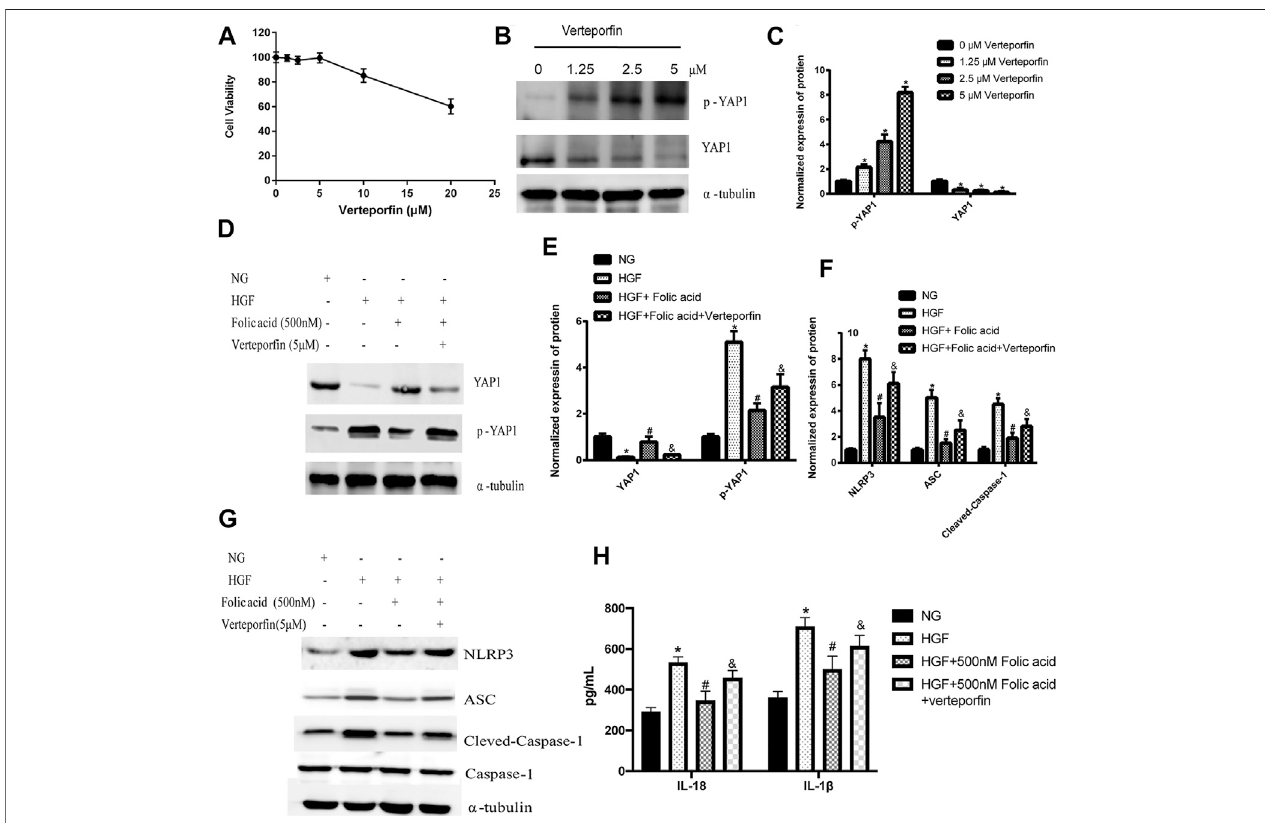
FIGURE 5 | Vertepor fi n decreased the protective effect of folic acid on H9C2 cells by inhibiting YAP expression. (A) The effect of vertepor fi n on the percentage of viableH9C2cells. (B) RepresentativeimmunoblotshowingexpressionlevelsofYAPandp-YAPinH9C2cellstreatedwithvertepor fi n. (D,G) Representativeimmunoblot showing levels of NLRP3, ACS, Cleaved-Caspase-1, Caspase-1, YAP and p-YAP. (H) IL-1 β and IL-18 levels in the cell supernatant. (C, E, F) Quanti fi cation of YAP1, p-YAP1, NLRP3, ACS, with α -tubulin as the loading control, for Cleaved-caspase-1, Caspase-1 as the loading control. * p < 0.05, compared with NG; # p < 0.05, compared with HGF, & p < 0.05, compared with HGF + Folic